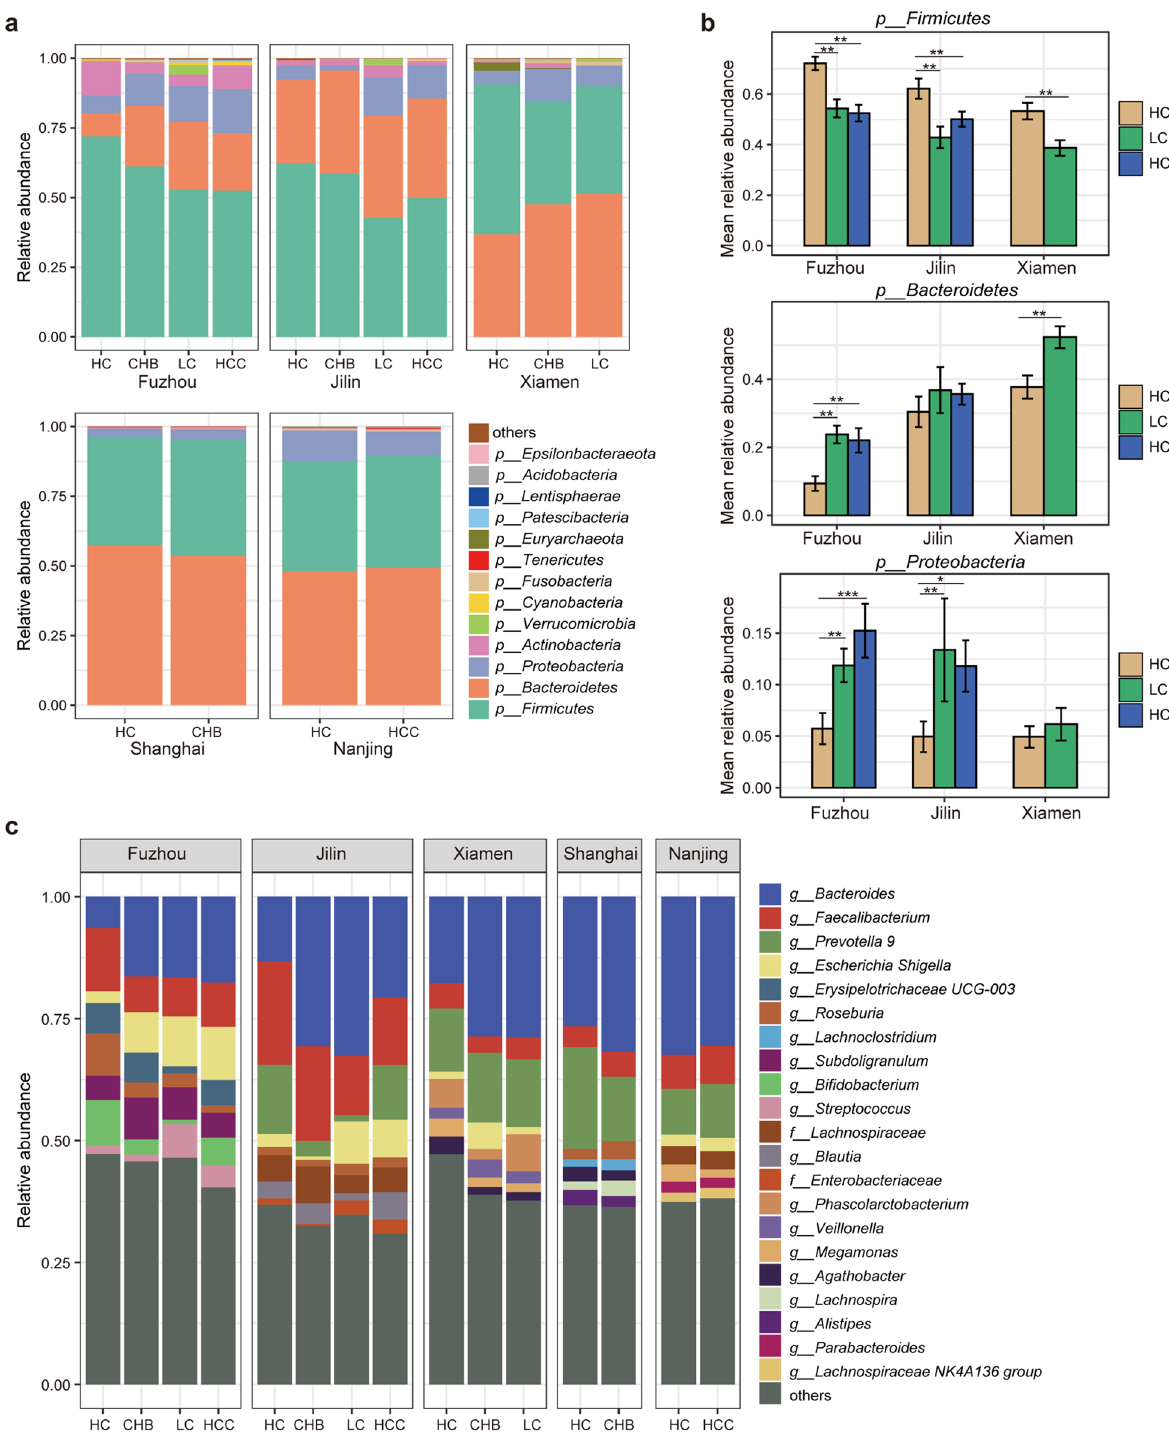
Fig. 2 Distribution of the predominant bacteria at the phylum and genus levels in five datasets. a Stacked bars of the microbial composition at the phylum level among HC, CHB, LC and HCC. b Bar chart of the relative abundance of predominant taxa at the phylum levels in LC and HCC compare to HC. Wilcoxon rank sum test was used to compare the difference. *: p < 0.05, **: p < 0.01, ***: p < 0.001. c Stacked bars of the microbial composition at the genus level among HC, CHB, LC and